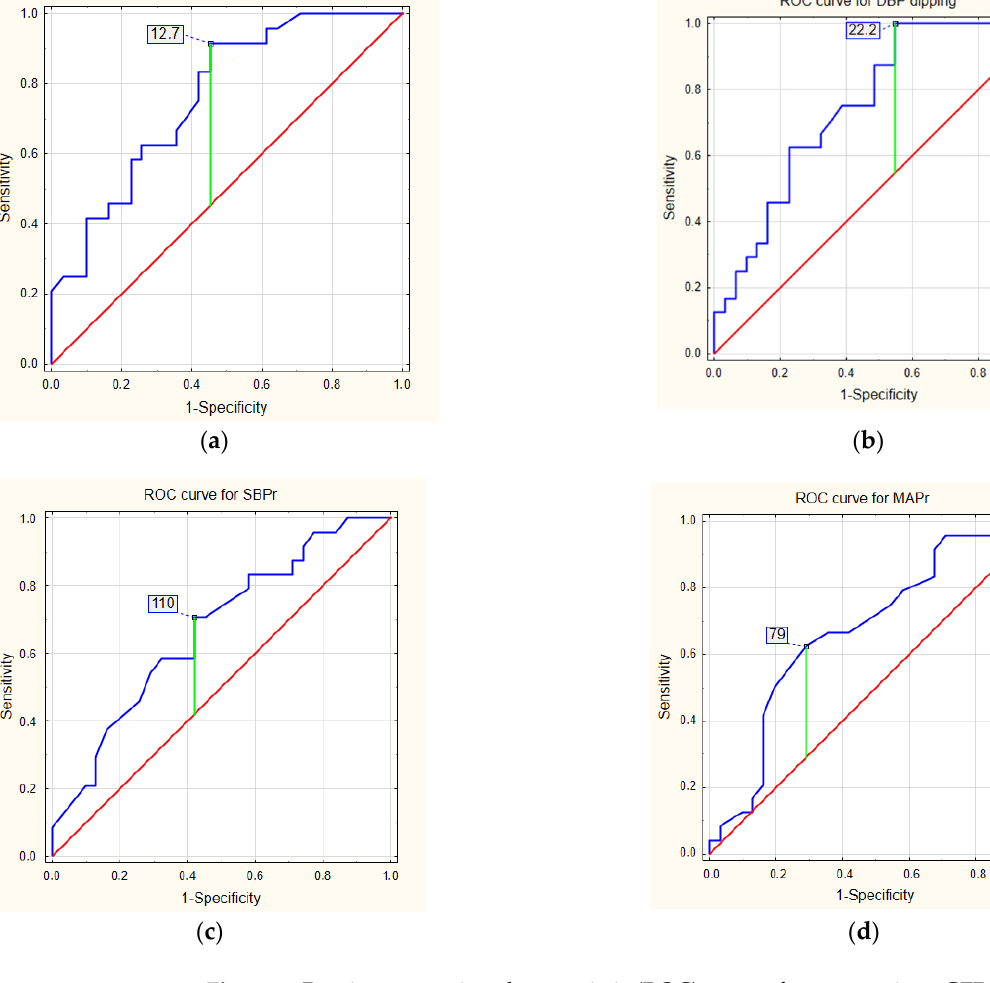
Figure 3. Receiver operating characteristic (ROC) curves for prognosing eGFR slope ≥ 3 mL/min/1.73 m 2 /year by destimulants: ( a ) SBP dipping and ( b ) DBP dipping; stimulants: ( c ) systolic blood pressure during rest and ( d ) mean arterial pressure during rest.